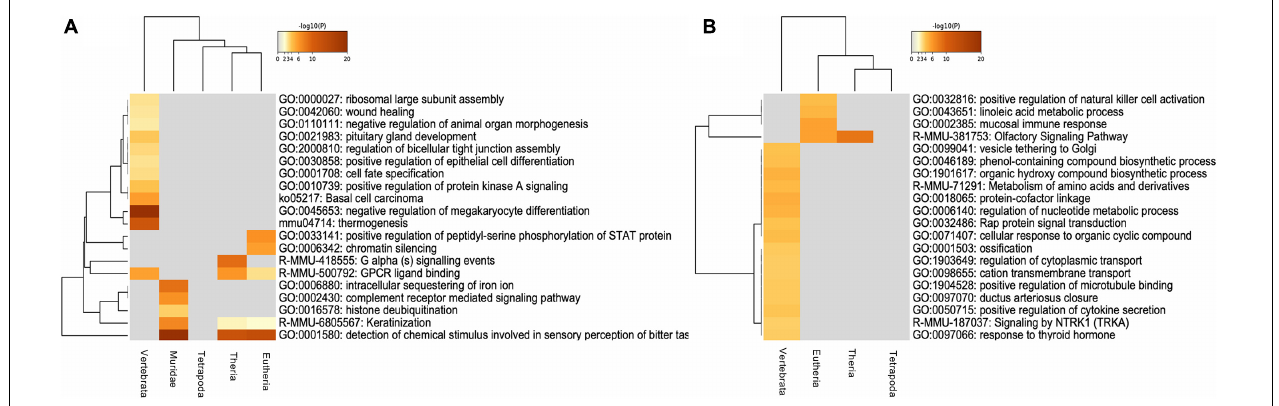
FIGURE 10 | Functional enrichment of conserved mouse IG and MEG orthologs. (A) Gene ontology enrichment and pathways for mouse IG conserved as IG in the selected species, orthologs are clustered regarding their “age” group. (B) Gene ontology enrichment and pathways for a sample of 1,116 mouse MEGs conserved as MEG in the selected species, orthologs are clustered regarding their “age” group. The color key from yellow to brown indicates high to low p -values,